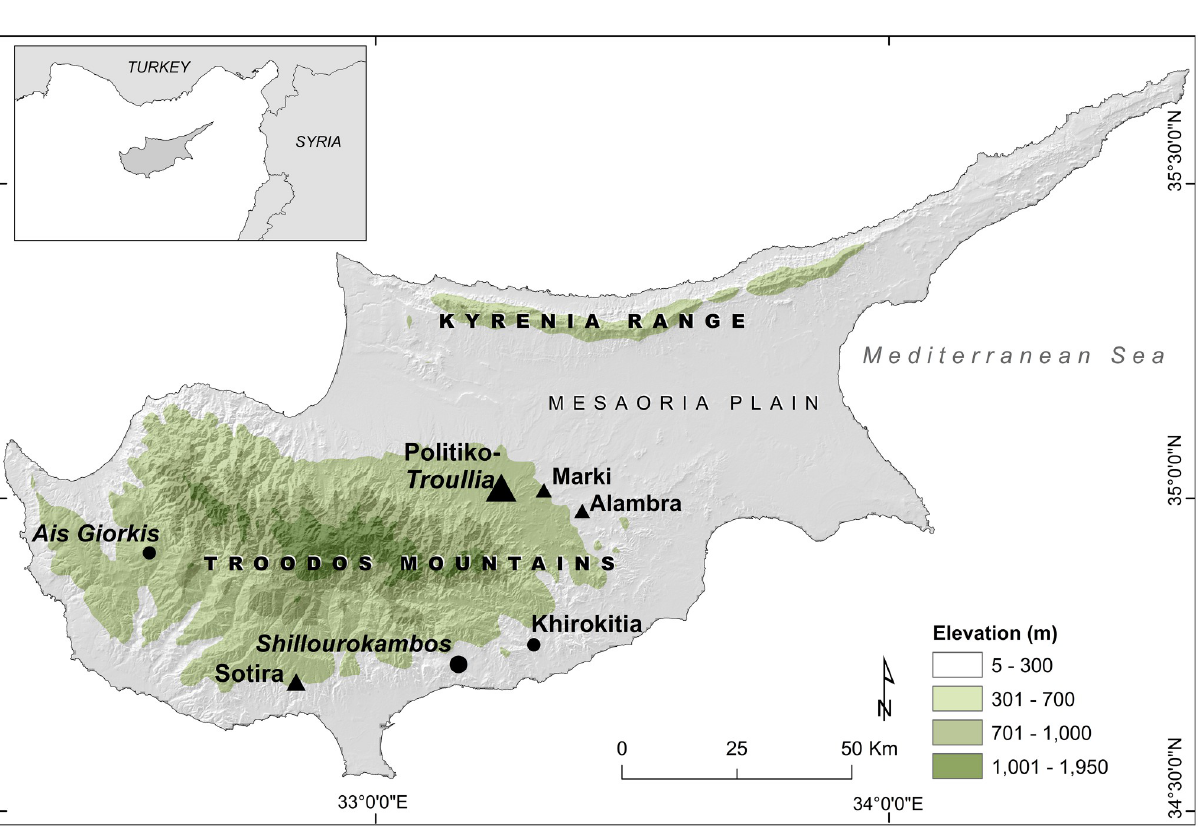
Fig 1. Map of Cyprus showing locations of Bronze Age sites (triangles), including Politiko- Troullia , and Neolithic sites (circles) mentioned in text. This figure was produced using ESRI ArcGIS version 10.8.x.